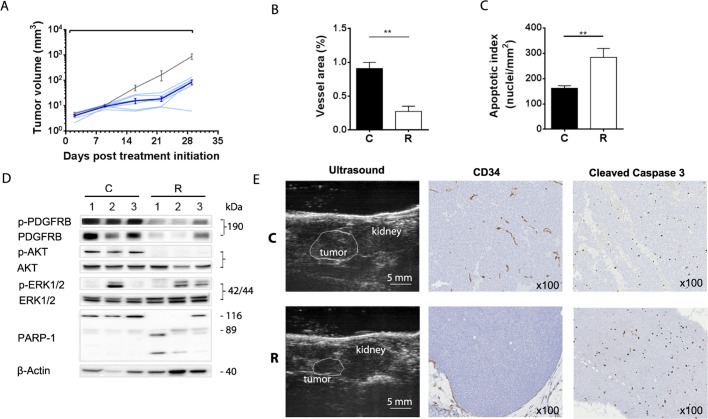
Regorafenib inhibits orthotopic IGR-N91-Luc neuroblastoma through antiangiogenic effects and induction of apoptosis.Animals bearing orthotopic adrenal IGR-N91-Luc tumors were treated orally with regorafenib at 30 mg/kg/d (blue lines) or vehicle (grey line) for 28 days. (A) Graph shows growth curves of individual regorafenib treated mice and arithmetic means (± SEM) of tumor volumes of 7 untreated and 6 treated tumors. Tumor volumes were determined by ultrasonography and representative images of adrenal tumors and kidneys at Day 22 post treatment initiation are displayed (E). Paraffin-embedded entire sections of adrenal IGR-N91-Luc xenografts from Day 29 post treatment initiation were stained immunohistochemically with antibodies against the endothelial cell marker protein CD34 and the apoptosis marker cleaved caspase 3. (B) Microvessel area, quantified as number of CD34-positive vessel using Calopix software, is presented as means ± SEM of 6 controls and 4 treated tumors (p = 0.0095; Mann-Whitney). (C) Apoptosis index is determined as number of caspase 3 cleavage positive cells in 6 controls and 6 treated tumors (p = 0.0043). Examples of histological stainings are shown at 100x magnification. Positive staining appears as brown color (E). (D) Total lysates of three individual tumors from Day 29 post treatment initiation were subjected to Western blot analyses using antibodies against phosphorylated (p-) and non-phosphorylated PDGFR, AKT, ERK1/2 and against cleaved PARP-1. β-actin was used as reference. C: control, R: regorafenib.